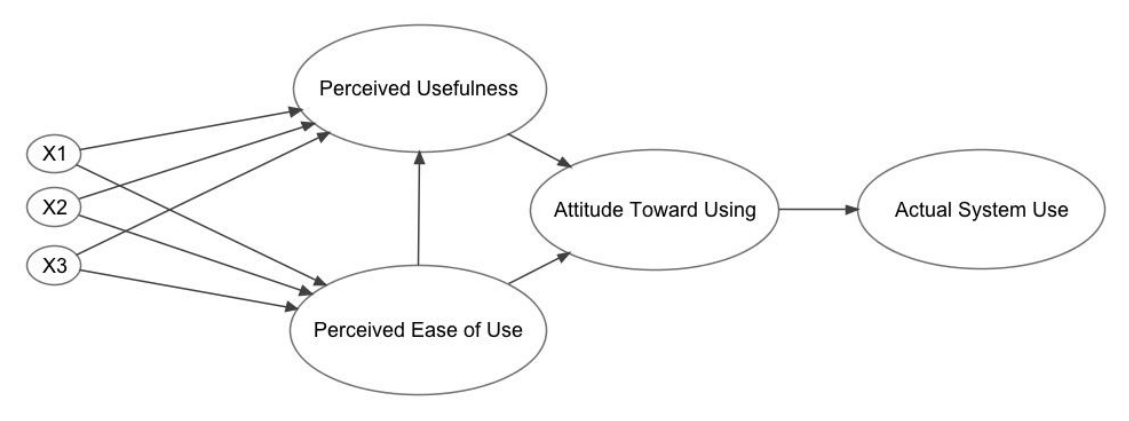
Figure 1. Correlation of original TAM factors. Reprinted from A technology acceptance model for empirically testing new end-user information systems: Theory and results (Doctoral dissertation), by Davis, 1986, Cambridge, MA : Sloan School of Management, Massachusetts Institute of Technology . Copyright 1986 by the Massachusetts Institute of